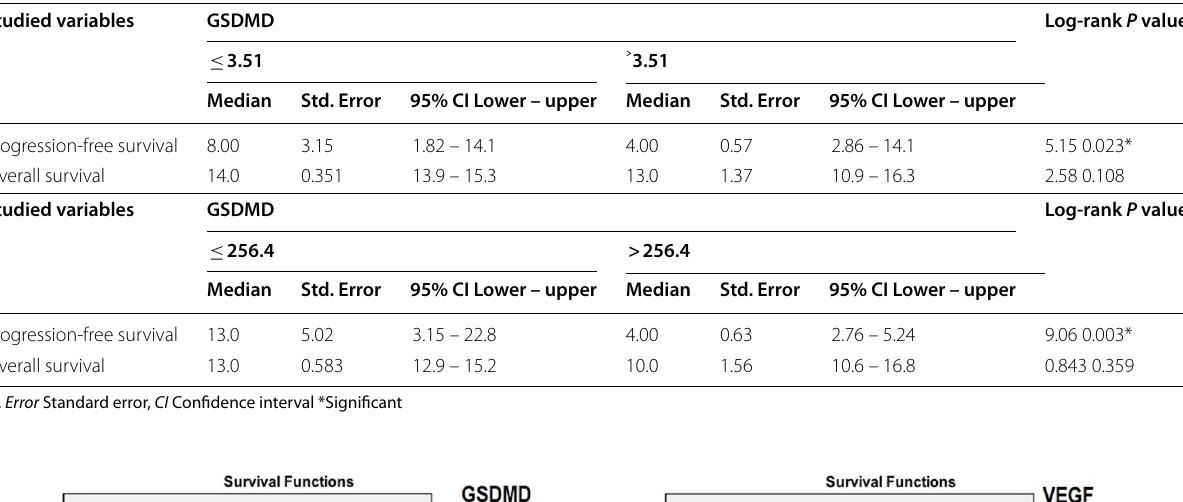
Table 8 Relation between GSMD and VEGF with progression‑free survival and overall survival among malignant pleural effusion group